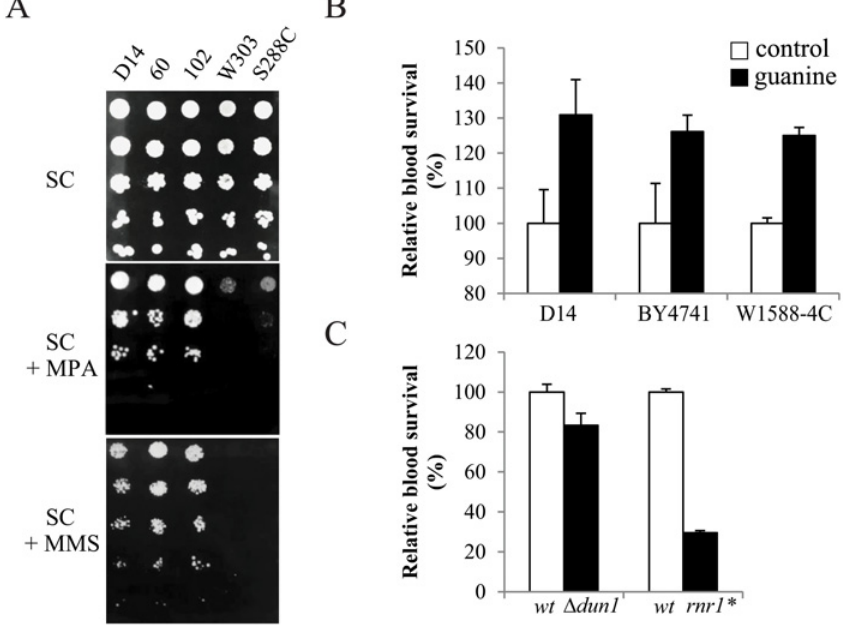
Fig 4. The critical role of genes related to dNTP pool increase in response to human blood phagocytes. A) Evaluation of yeast performance in response to 7 μ g/ml of mycophenolic acid (MPA) or 0.004% of MMS was compared to control minimal media SC for opportunistic strains D14, 102 and 60 and for control lab strains S288C and W303. B) Evaluation of yeast survival after 90 min of ex vivo human blood incubation. After blood incubation, wild type lab strains BY4741 and W1588-4C and D14 opportunistic strain were plated in YPD or YPD with guanine (65 μ M) and colony were counted. C) Also, dun1 and rnr1 * mutants were plated in YPD after blood exposure. Triplicates average and standard deviation of normalized survival data (YPD + guanine respect YPD and mutants respect its isogenic parental wild type) is represented. In all cases (control respect guanine and mutants respect to wild type) differences were significantly different using p -value of